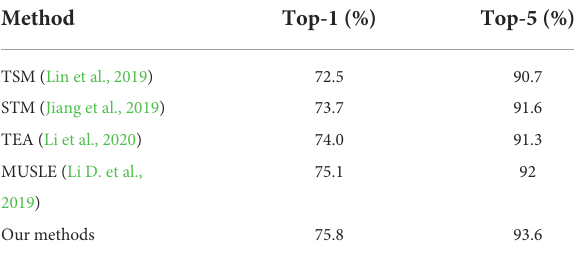
TABLE 3 Exploration of PR.